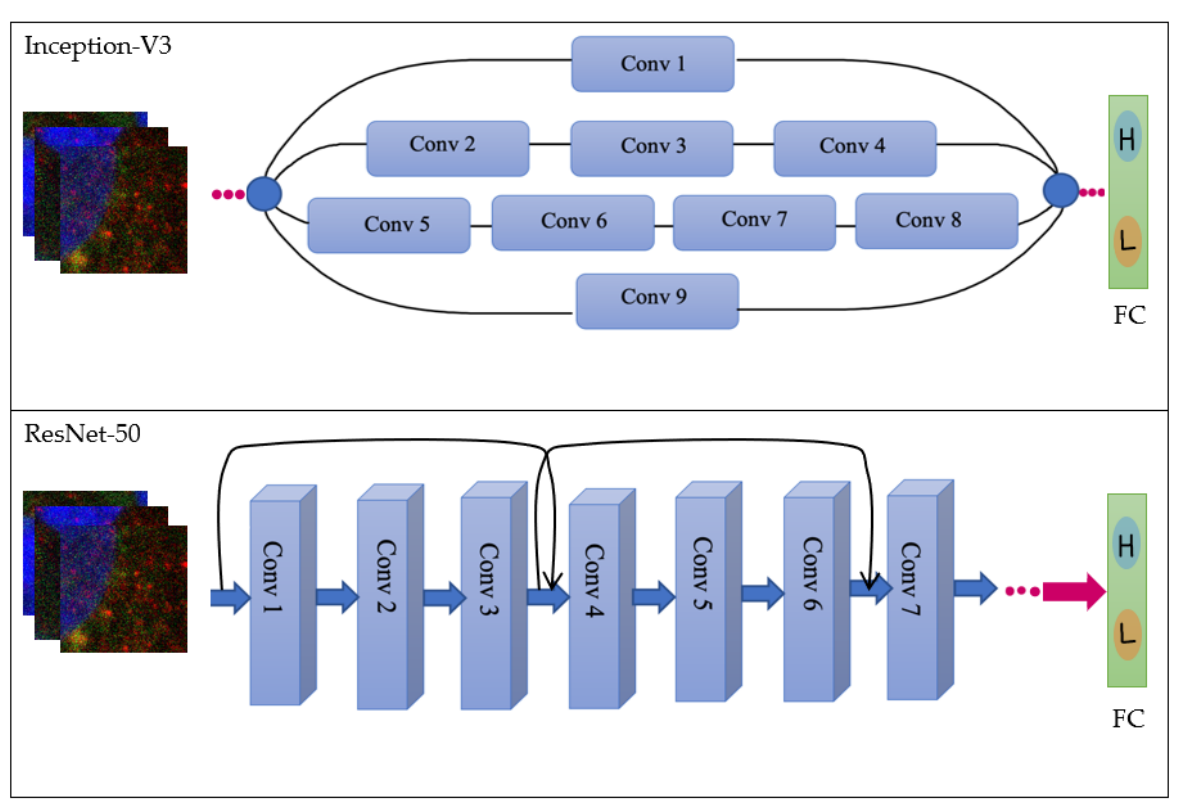
Figure 11. Architecture of the pre-trained models [37].